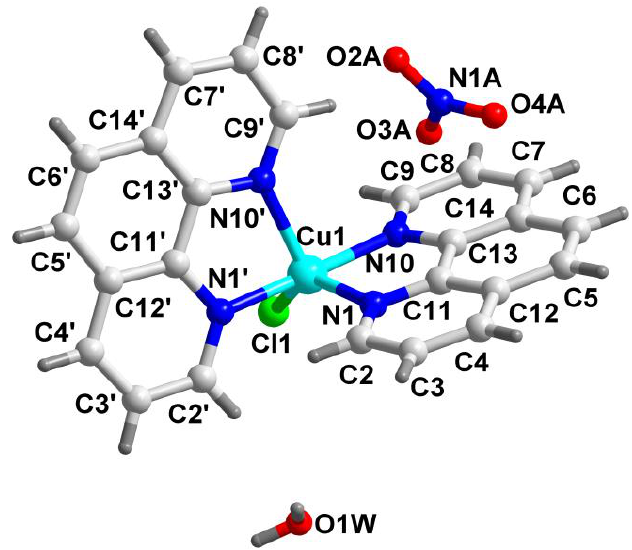
Figure 1. Molecular structure of [Cu(phen) 2 Cl]NO 3 ·H 2 O ( 1 ). Table 2. Selected bond lengths (Å) and bond angles (°) of the Cu(II) centers in compounds 1 and 2 .